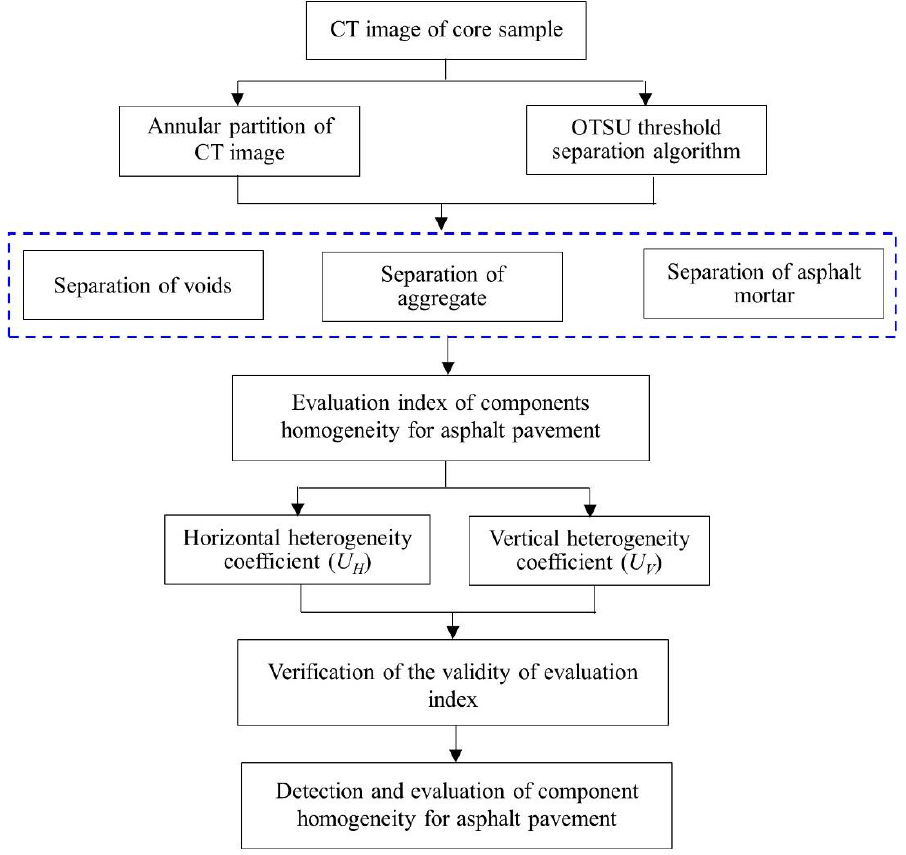
Figure 1. The flow chart for the research